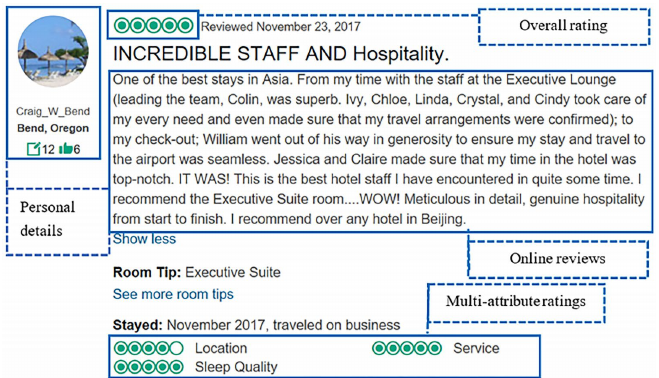
Figure 12. The online information on TripAdvisor